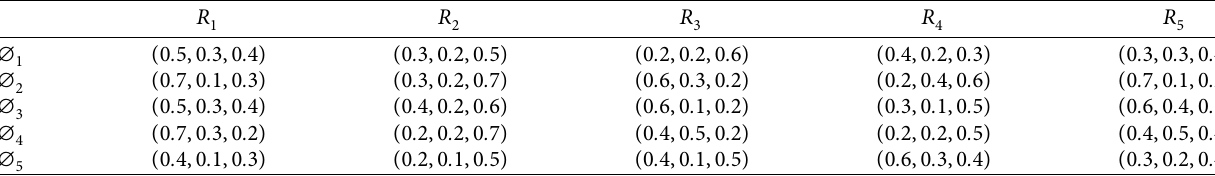
Table 1: Expert evaluation information.